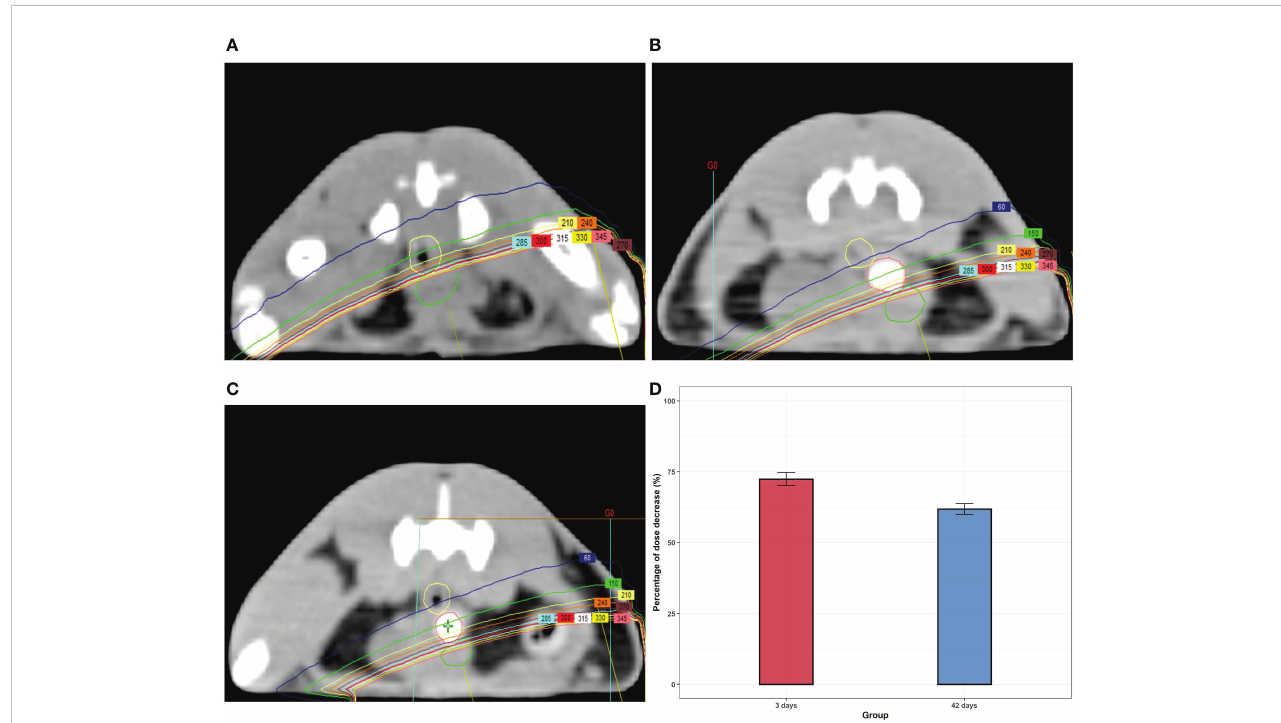
FIGURE 3 The dose distributions from the axial CT section of rats with or without (A) hydrogel at day 3 (B) and day 42 (C) . (D) The percentage of the dose-drop at day 3 and day